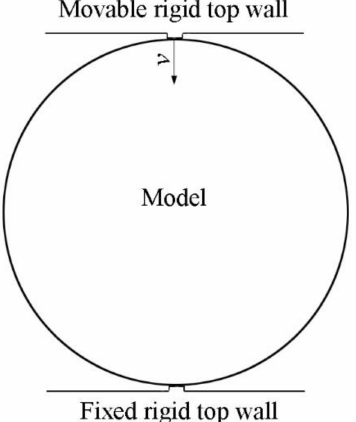
Figure 5. Boundary condition of the model.